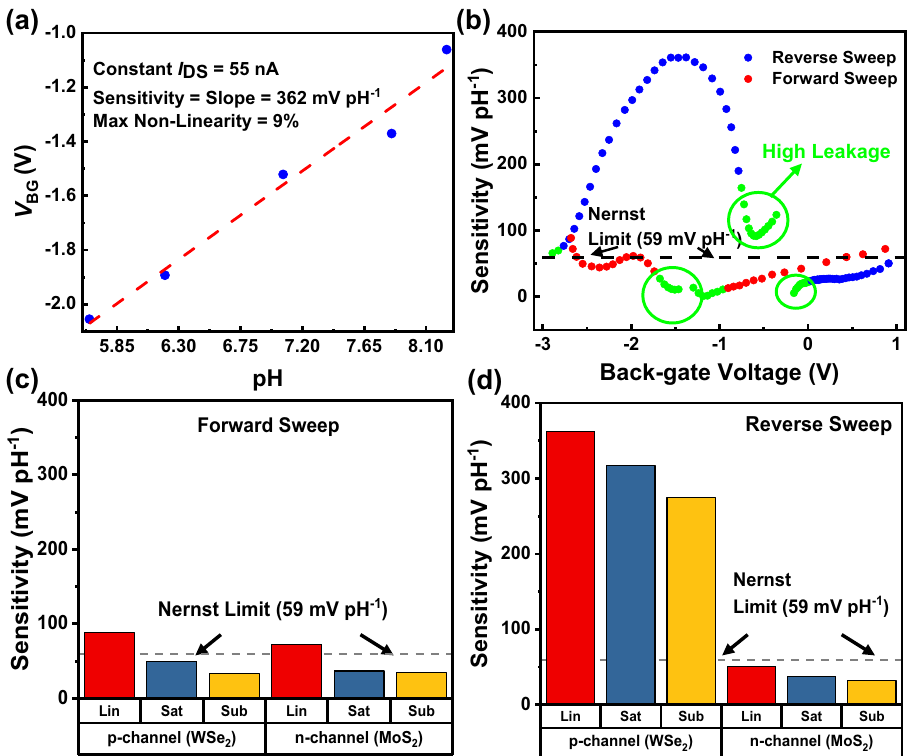
Fig. 3 Sensitivity. a Back-gate voltage ( V BG ) against pH at constant drain current, b Voltage sensitivity ( S V ) with respect to the V BG of the transfer curve at pH = 7. Peak S V at linear, saturation, and subthreshold region of operation during c forward sweep and d reverse sweep for the WSe 2 (top)/MoS 2 (bottom)